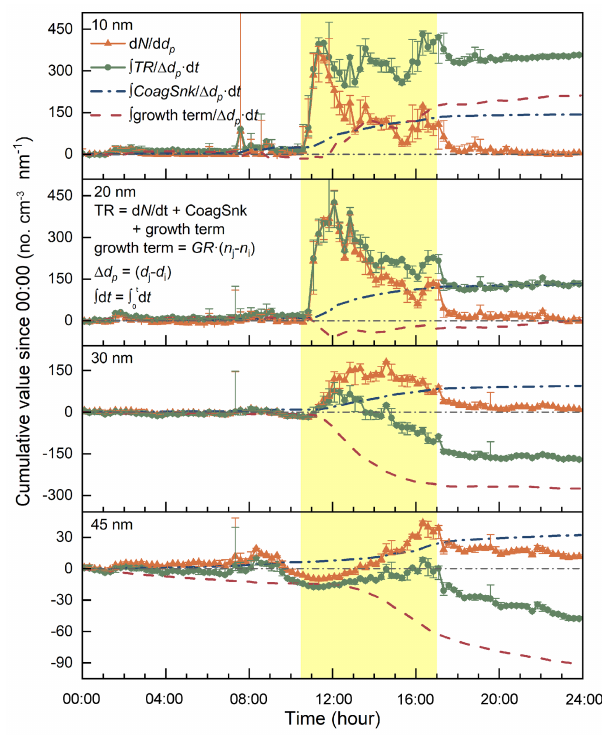
Figure 5. The time series of d N / d d p (i.e., the cumulative d N / d t ), the cumulative transport term, the cumulative CoagSnk, and the cumulative growth term in Eq. (11) at four different diameters on 12 August 2016, at the Lulang River valley. Note that d N / d d p rep- resented by orange symbols and lines was zero at 00:00 according to Eq. (11). The d N /d d p and TR were averaged every 15min, and the error bars indicate the maximum and minimum values in the corresponding time bins. The period of time when wind blew from north (indicating the valley breeze) is shaded with light